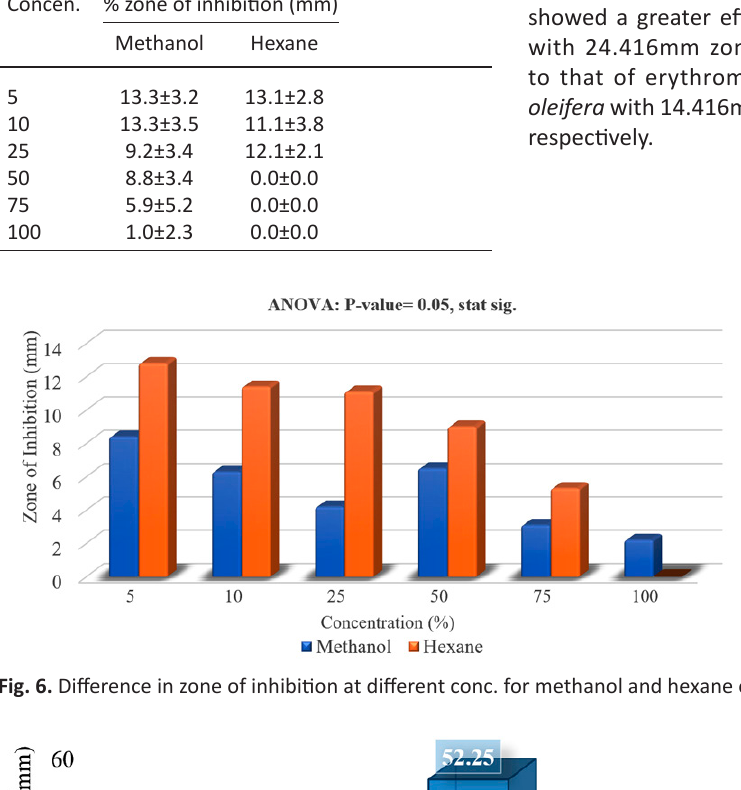
Table 8. Mean and Standard deviation for methanol and hexane extracts for M. oleifera at 100%, 75%, 50%, 25%, 10% and 5% concentration against P. aeruginosa Concen. % zone of inhibition (mm)